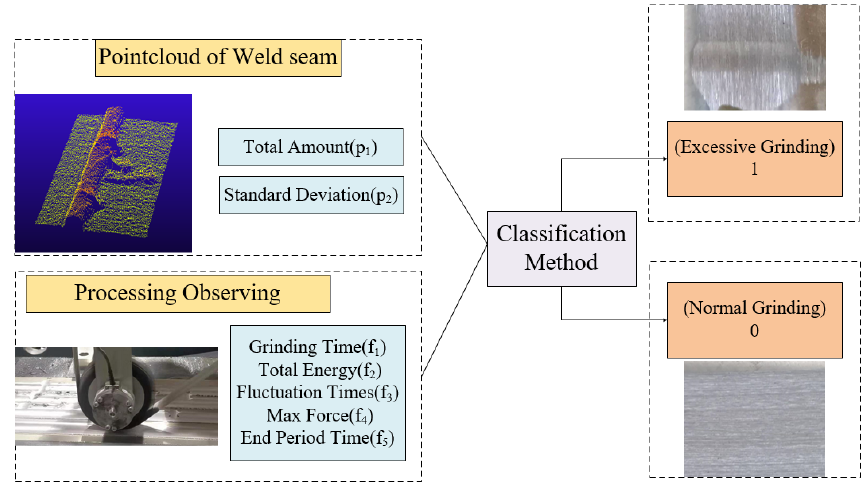
Figure 7. Classification method for